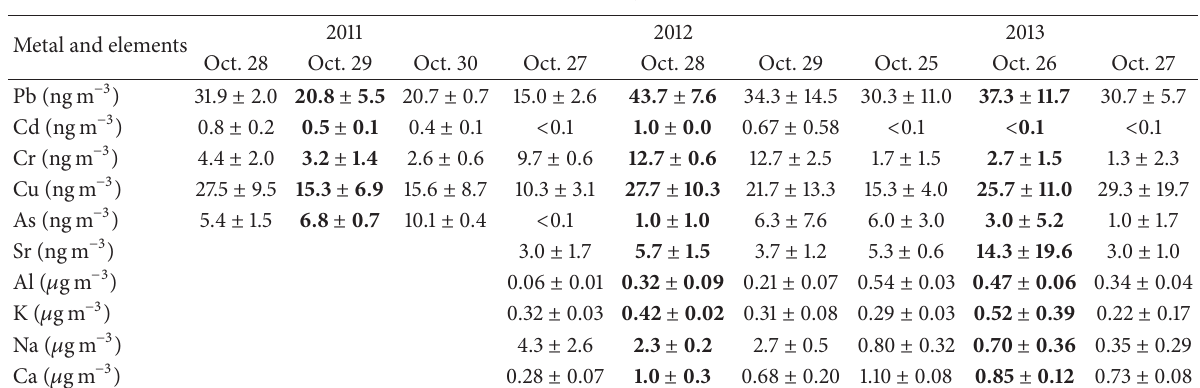
(Table 1 and Figure 3). In 2012, the distributions of trace metal concentrations were somewhat different from those in